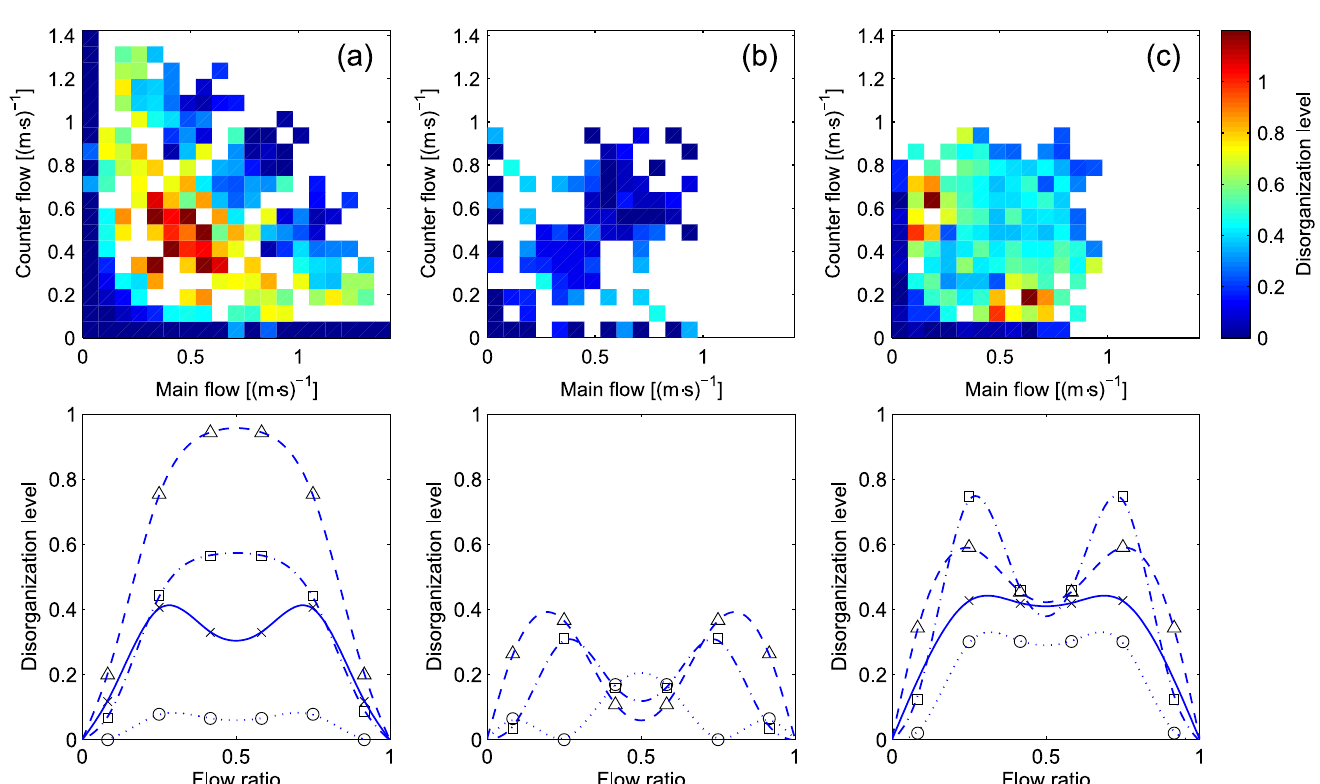
Fig 12. Disorganization level. The same color scale is used for all scatter plots. Interpretation for the flow ratio representation is provided in Table 4.